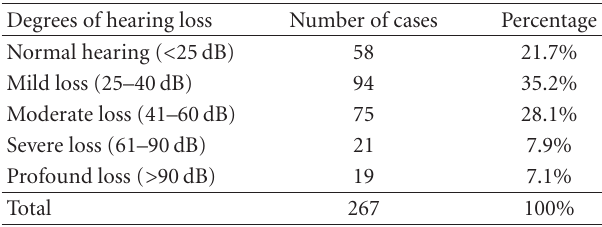
Table 2: The distribution of hearing outcomes based on the ABR test in the operating room.